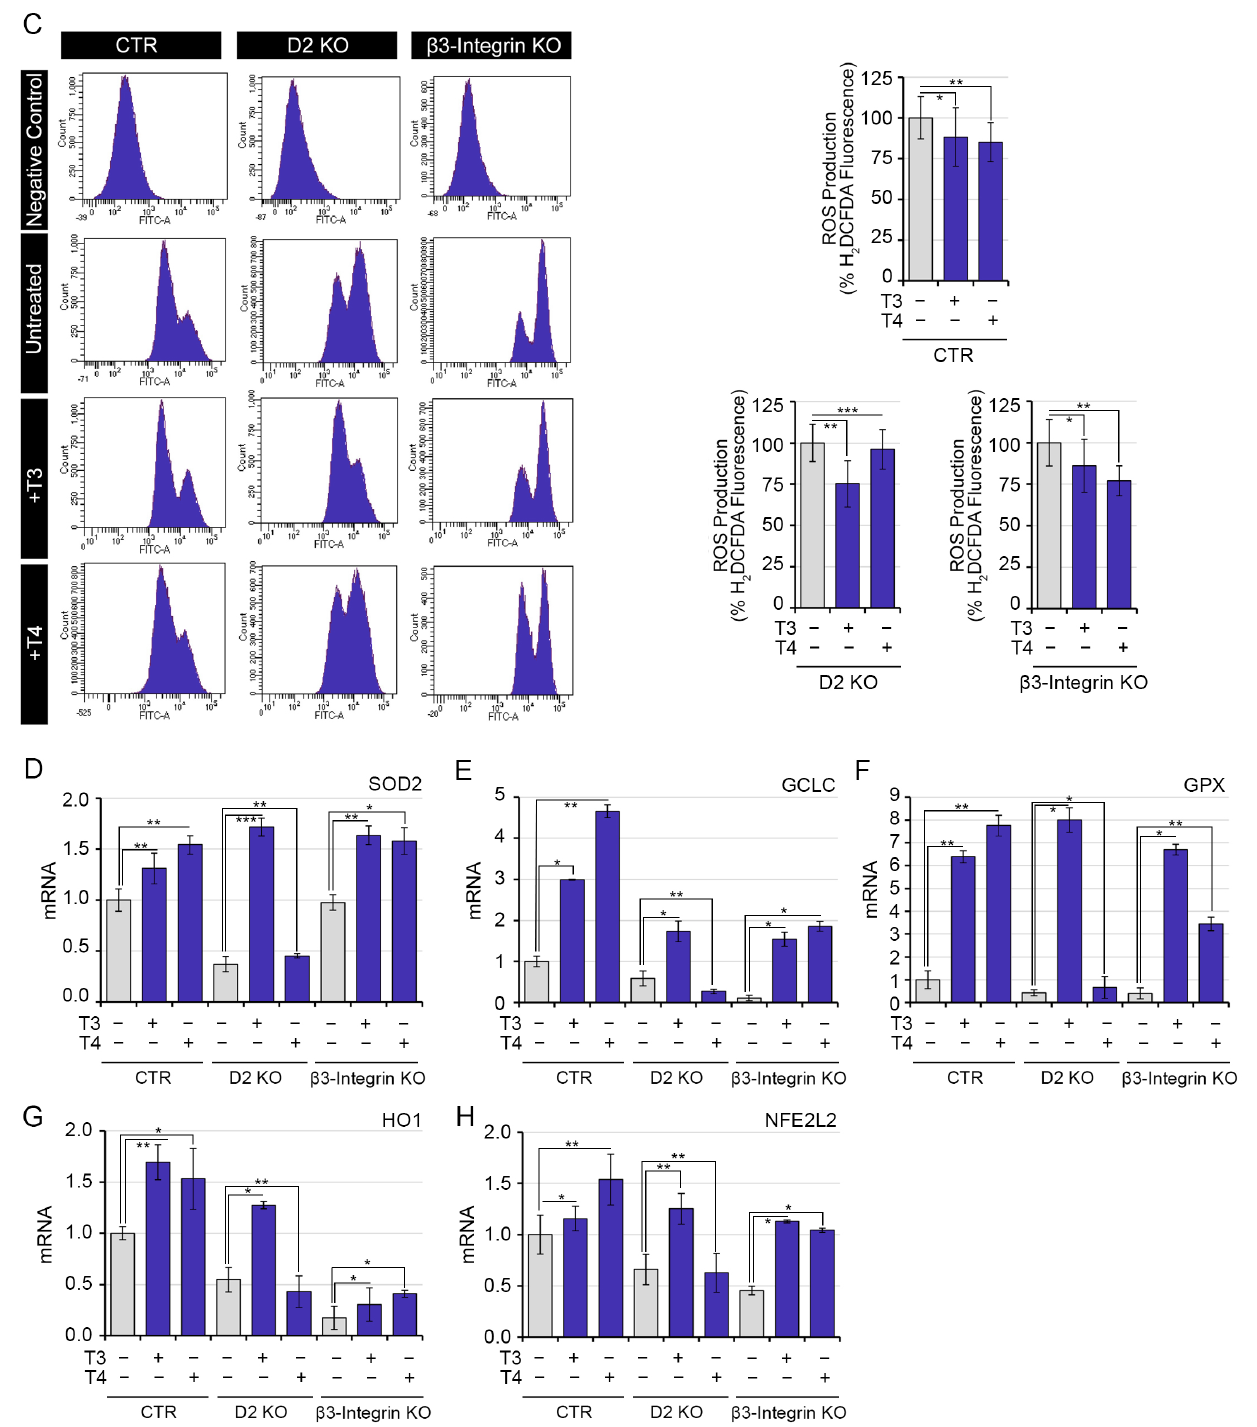
Figure 4. D2 and β 3-Integrin KO reduce endogenous ROS production. ( A ) Basal ROS were measured by FACS analysis in D2 KO, β 3-Integrin KO and CTR cells. Right panel shows the relative % mean of H 2 DCFDA fluorescence compared to CTR cells arbitrarily set as 100%. ( B ) mRNA expression of a panel of antioxidant genes, as SOD2, GCLC, GPX, HO1 and NFE2L2, was evaluated by real-time PCR in D2 KO, β 3-Integrin KO and CTR cells. ( C ) Basal ROS were measured by FACS analysis in D2 KO, β 3-Integrin KO and CTR cells treated with 30.0 nM T3 or T4. Right panels show the relative % mean of H 2 DCFDA fluorescence of D2 KO, β 3-Integrin KO and CTR cells, each compared to its untreated control. ( D – H ) mRNA expression of a panel of antioxidant genes, as SOD2, GCLC, GPX, HO1 and NFE2L2, was evaluated by real-time PCR in D2 KO, β 3-Integrin KO and CTR cells treated with 30.0 nM T3 or T4. * p < 0.05, ** p < 0.01, *** p <